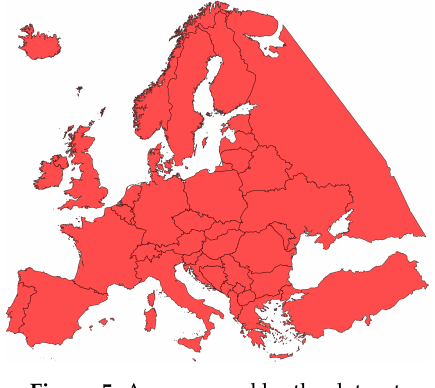
Figure 5. Area covered by the dataset. Table 4. Countries and territories covered by the dataset.